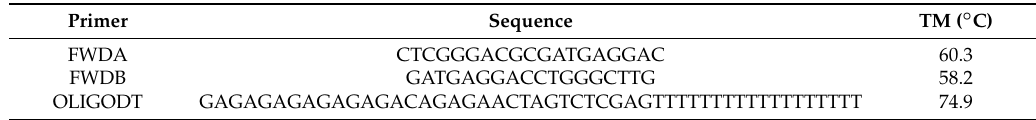
Table 1. PDGFA gene